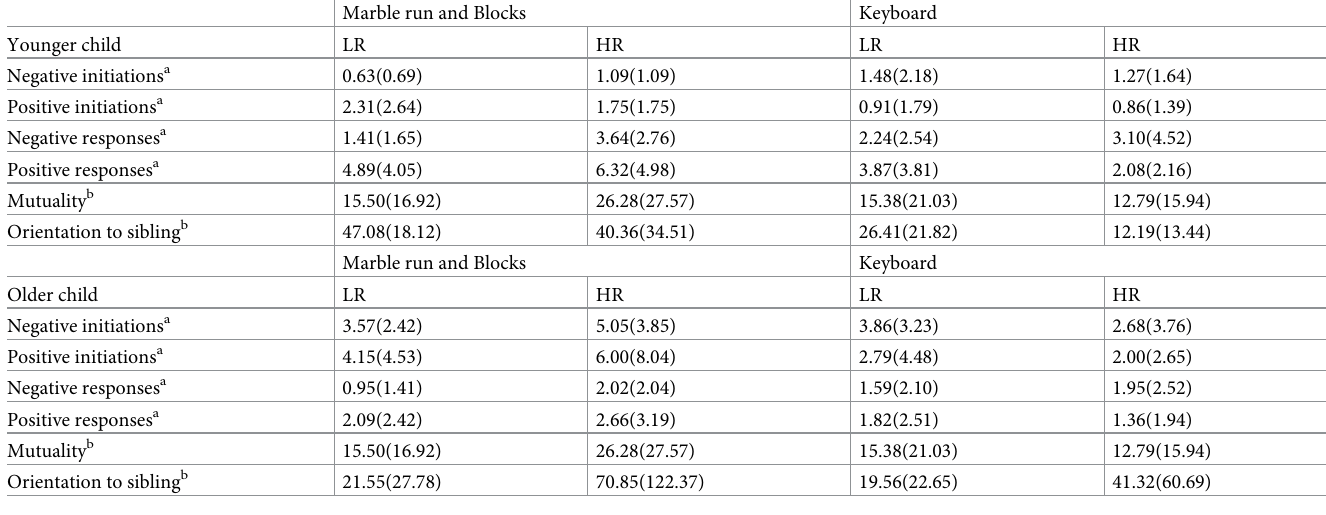
Table 2. Means (standard deviations) of sibling interaction characteristics. Marble run and